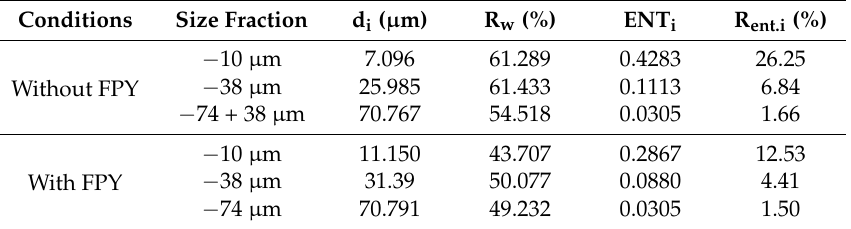
Table 4. The particle size data for the three size fractions after reacting with or without FPY.